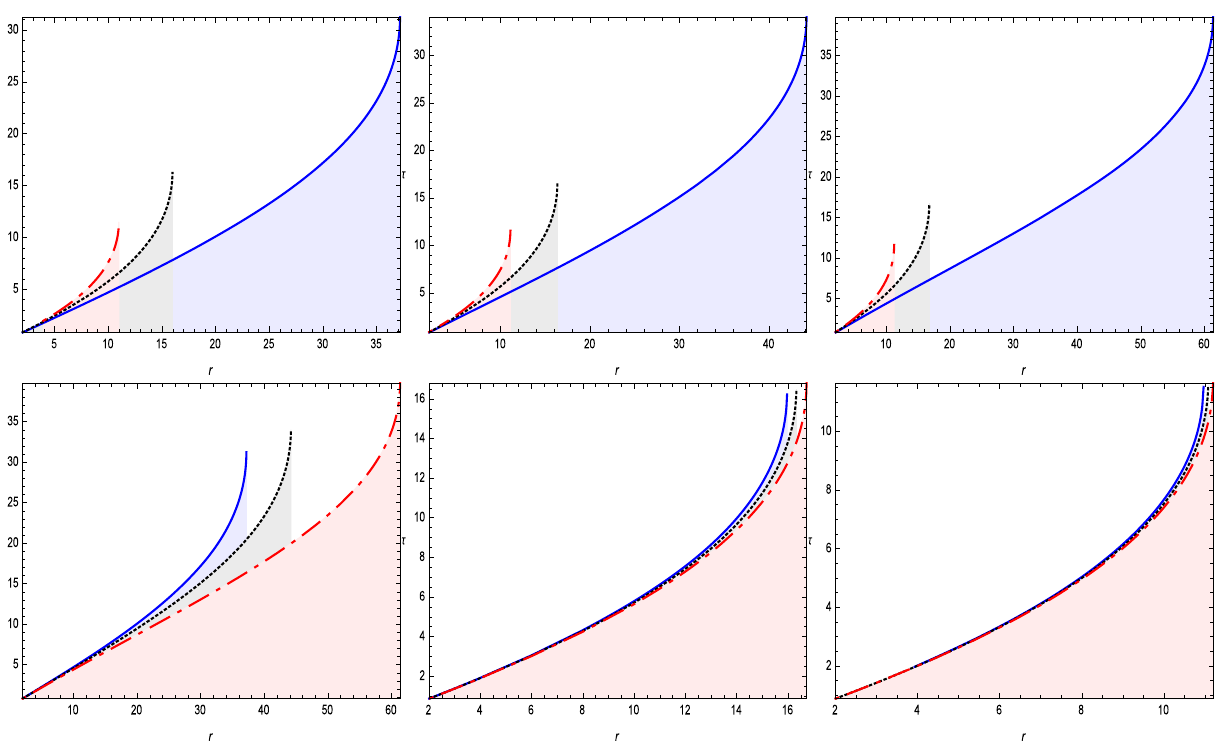
Fig. 4 Shows the behavior of τ for the different possible values of a and q . The left panel of the first row represents a = 0 . 1 (blue), a = 0 . 15 (black), and a = 0 . 2 (red) with q = 0 . 0010. The middle panel of the first row represents a = 0 . 1 (blue), a = 0 . 15 (black), and a = 0 . 2 (red) with q = 0 . 0011. The right panel of the first row represents a = 0 . 1 (blue), a = 0 . 15 (black), and a = 0 . 2 (red) with q = 0 . 0012. The left